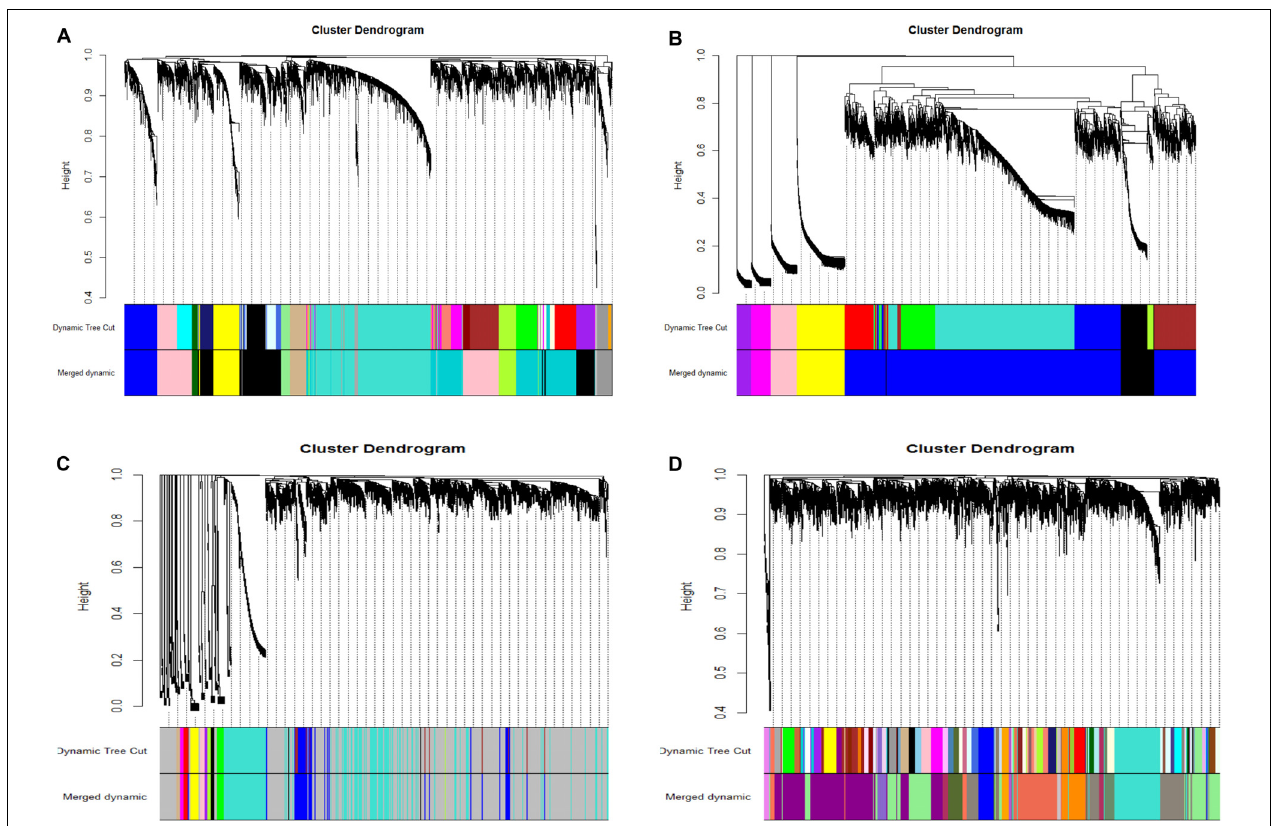
FIGURE 1 | Clustering of co-expression modules. Upper panel: genes were clustered into different groups, and assigned to network modules after dynamic tree cut and merging analyses (Lower panel). (A) NEAUHLF: preadipocyte microarray. (B) NEAUHLF: adipose tissue microarray. (C) French: adipose tissue RNA-seq. (D) French: adipose tissue